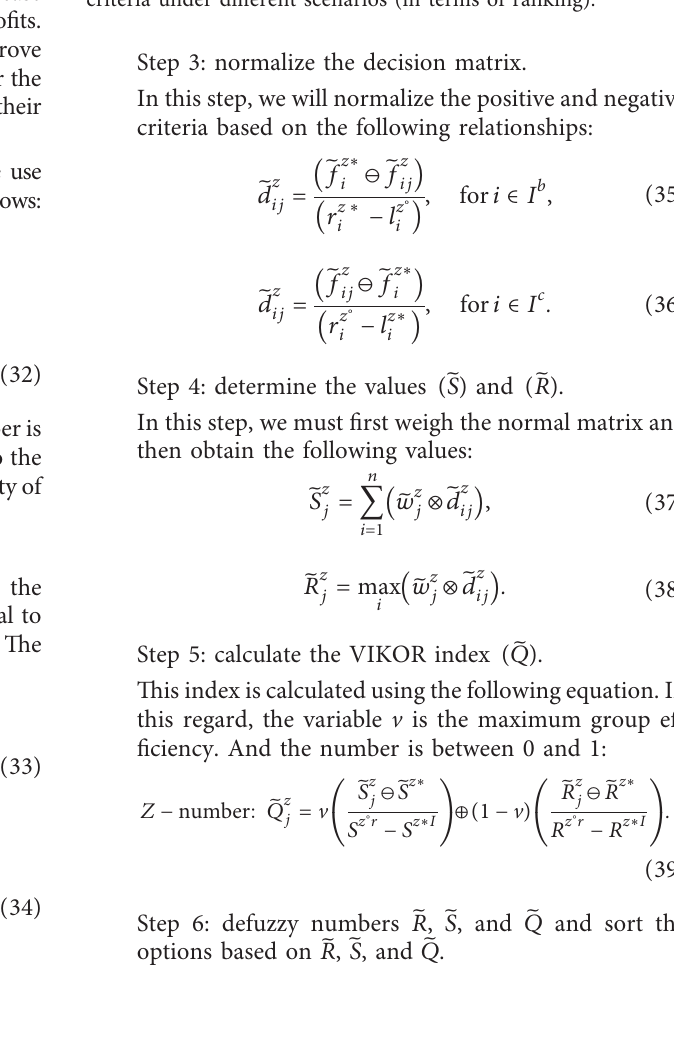
Figure 11: Comparison of importance weights of sustainability criteria under different scenarios (in terms of